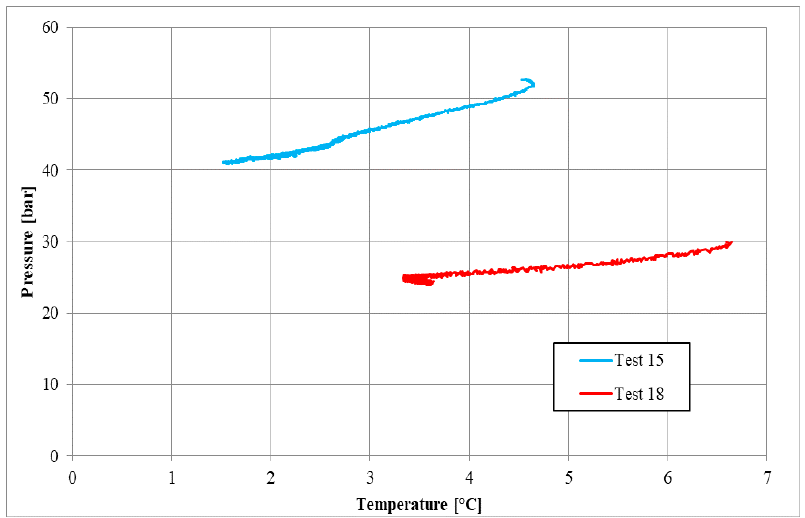
Figure 12. Comparison between Test 15, carried out using CH 4 , and Test 18, performed with CO 2.